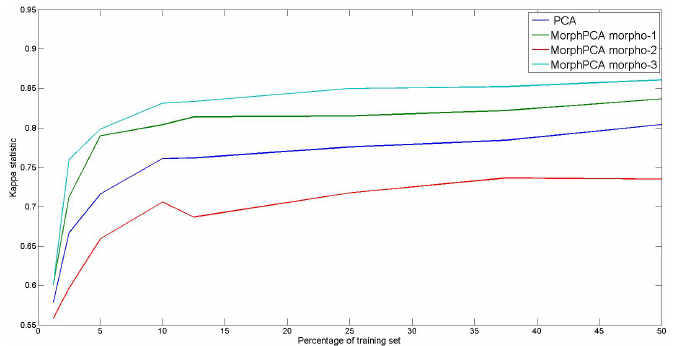
Figure 19. Results of kappa statistic for the least square SVM with a RBF kernel and different percentage of training set on Indian Pines hyperspectral image, the dimension of the reduced space is equal to